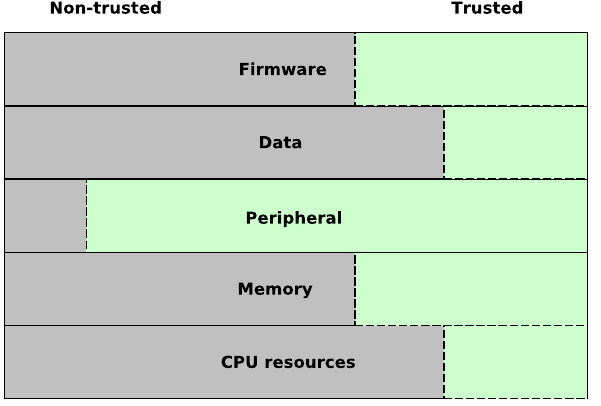
Figure 5. TrustZone view of a system address space and